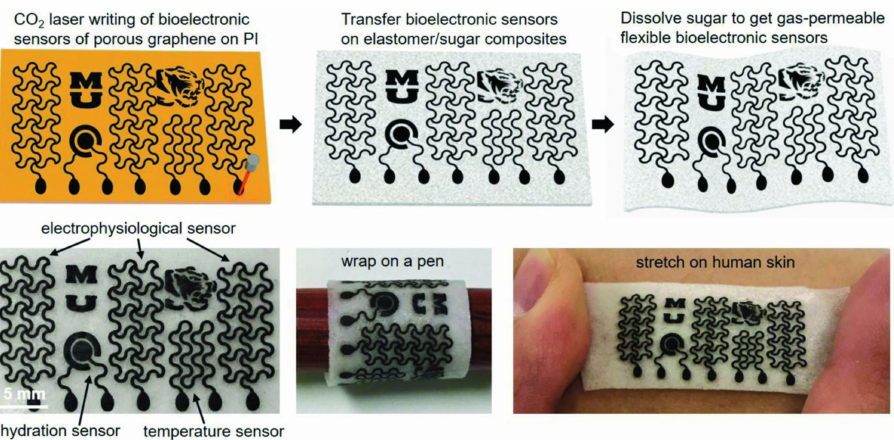
Figure 1. Gas-permeable and multifunctional on-skin system. Reproduced with permission from [10]. Copyright 2018